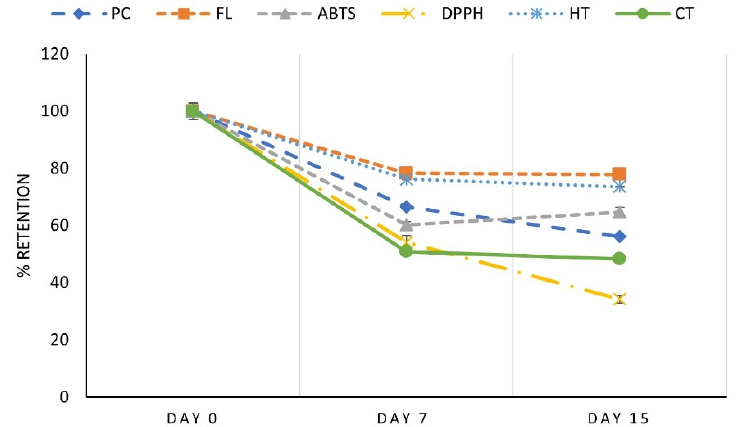
Figure 8. Retention (%) based on day 0 of bioactive compounds (PC, FL, AA (ABTS and DPPH), HT, CT) in jelly added with muicle extract MD microcapsules. CT) in jelly added with muicle extract MD